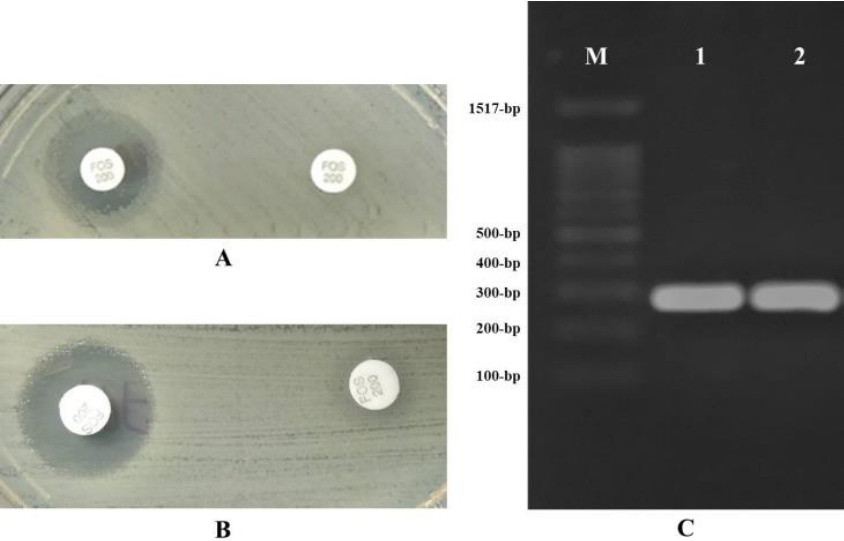
Figure 2. Detection of fosfomycin resistance-mediating glutathione S-transferase (sodium phosphonoformate test) and fosA3 gene (electrophoresis) in strains 66 and 871. ( A , B ) Phenotypic detection of fosfomycin resistance-mediating glutathione S-transferase in strains 66 and 871, respectively, showing an increase of ≥ 5 mm in growth inhibition halo around the disk of 200 µ g fosfomycin supplemented with 50 µ g G6P plus sodium phosphonoformate in comparison to the disk containing 200 µ g fosfomycin supplemented with 50 µ g G6P alone. All assays were performed in duplicate in all isolates, obtaining the same between-assay results; ( C ) Electrophoresis results for the PCR products of fosA3 gene (282 bp) on 0.8% agarose gel in strains 66 (line 1) and 871 (line 2). M: molecular weight.